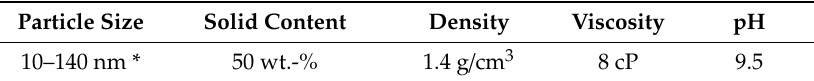
Table 1. Properties of colloidal silica.